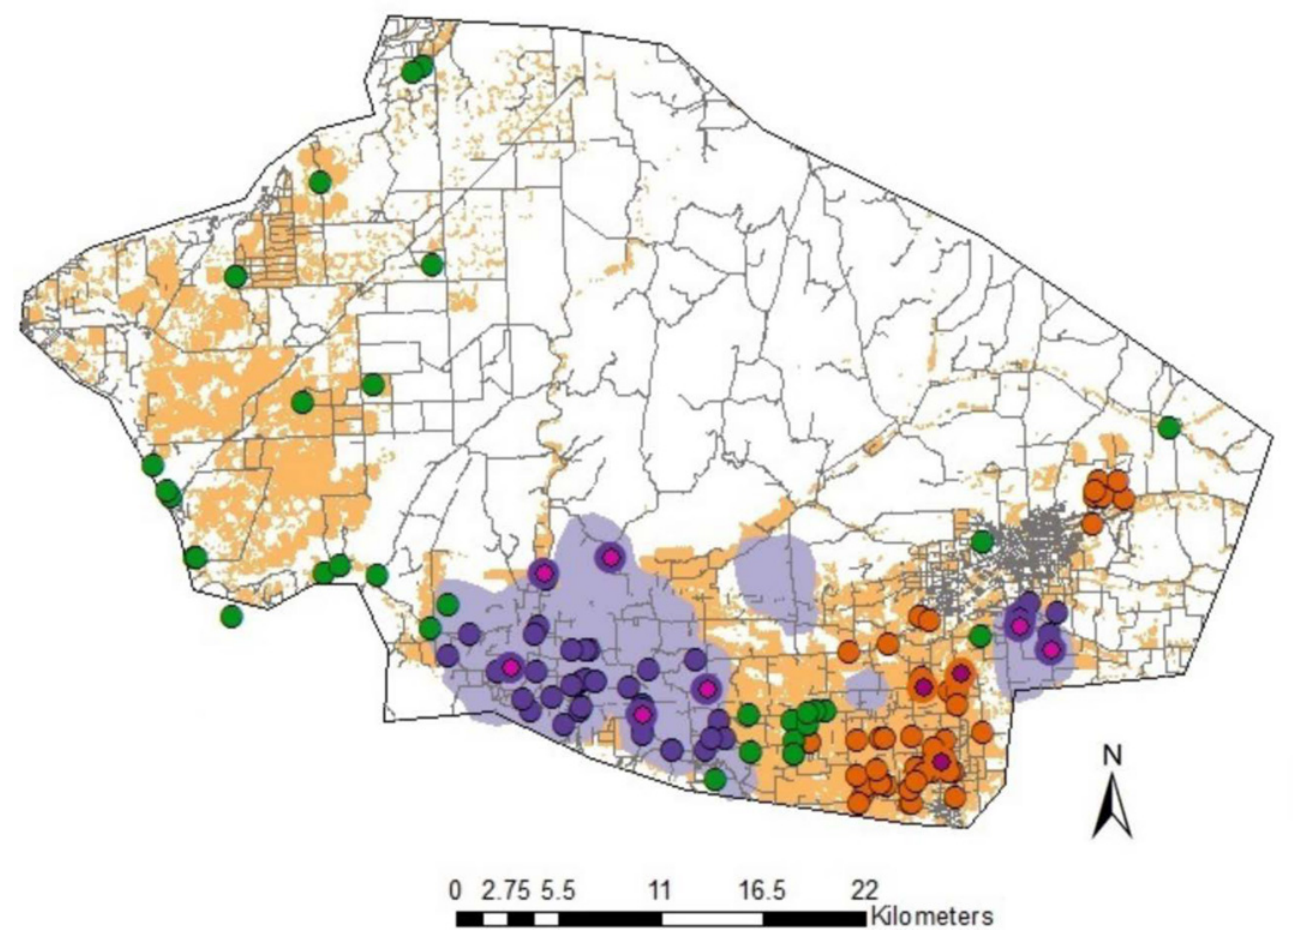
Fig 3. Distribution of roadside feral alfalfa plants in Walla Walla County, Washington. Hot spot analysis showed significant clustering of roadside feral populations (dark purple, dark orange) in alfalfa-seed (purple) and hay-production (orange) areas. Non-clustering populations are also evident (green). Transgenic feral populations (pink) were clustered in seed and hay production areas.